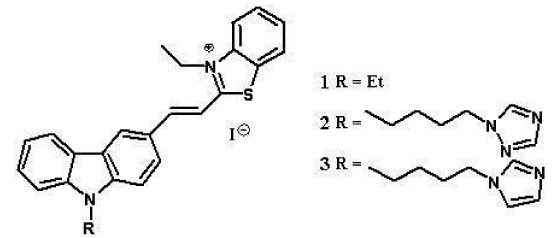
Figure 1. Structures of carbazole ligands 1 – 3